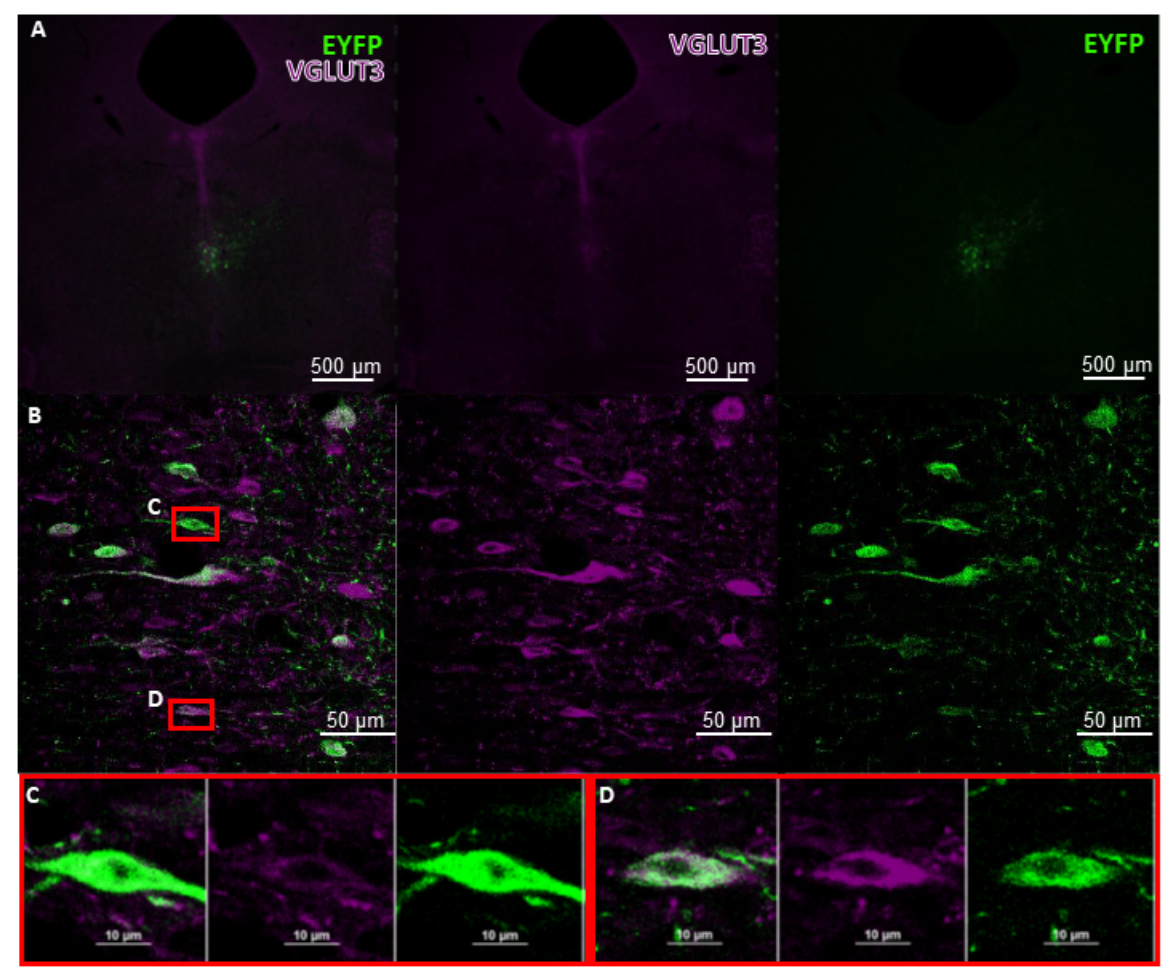
Figure 4. Proper functioning of Cre system in the MR. VGLUT3 ‐ Cre mouse acquired from the Jacksons Laboratory (USA; stock No.: #028534) and bred locally at the Institute of Experimental Medicine was injected with AAV containing the sequence of EYFP in a DIO construct (Addgene, catalog No.: #20298 ‐ AAV5) (see Figure 2B). Brain slices of 30 μ m thickness were stained with a ‐ VGLUT3 (rabbit, Synaptic Systems, stock No.: #135203) and a ‐ EYFP (chicken, Life Technologies, stock No.: #A10262), then with Alexa ‐ 647 conjugated a ‐ rabbit (donkey host, Jackson, stock No.: #711 ‐ 605 ‐ 152) and Alexa ‐ 488 conjugated a ‐ chicken (goat host, Life Technologies, stock No.: #A11039) antibodies, respectively. EYFP ‐ positive (green) cells represent Cre activity. ( A ) Viral staining in the whole MR. ( B ) Example of a proper Cre system functioning: VGLUT3+ (purple) neurons were able to inverse and express the gene sequence of EYFP that was coded in the injected AAV in the MR. We found no ectopic (that is, EYFP in non ‐ VGLUT3+ cells) expression. ( C , D ) Double immunofluorescent positive neurons in the MR. Double fluorescent immunohistochemistry was done by László Bíró, and the pictures were taken by him at the Nikon Centre at the Institute of Experimental Medicine with C2 confocal laser ‐ scanning microscope at 4×, 20×, and 60× magnification. AAV: adeno ‐ associated viral vectors; EYFP: enhanced yellow fluorescent protein; DIO: double ‐ floxed inverted open reading frame; MR: median raphe; VGLUT3: vesicular glutamate transporter type 3.